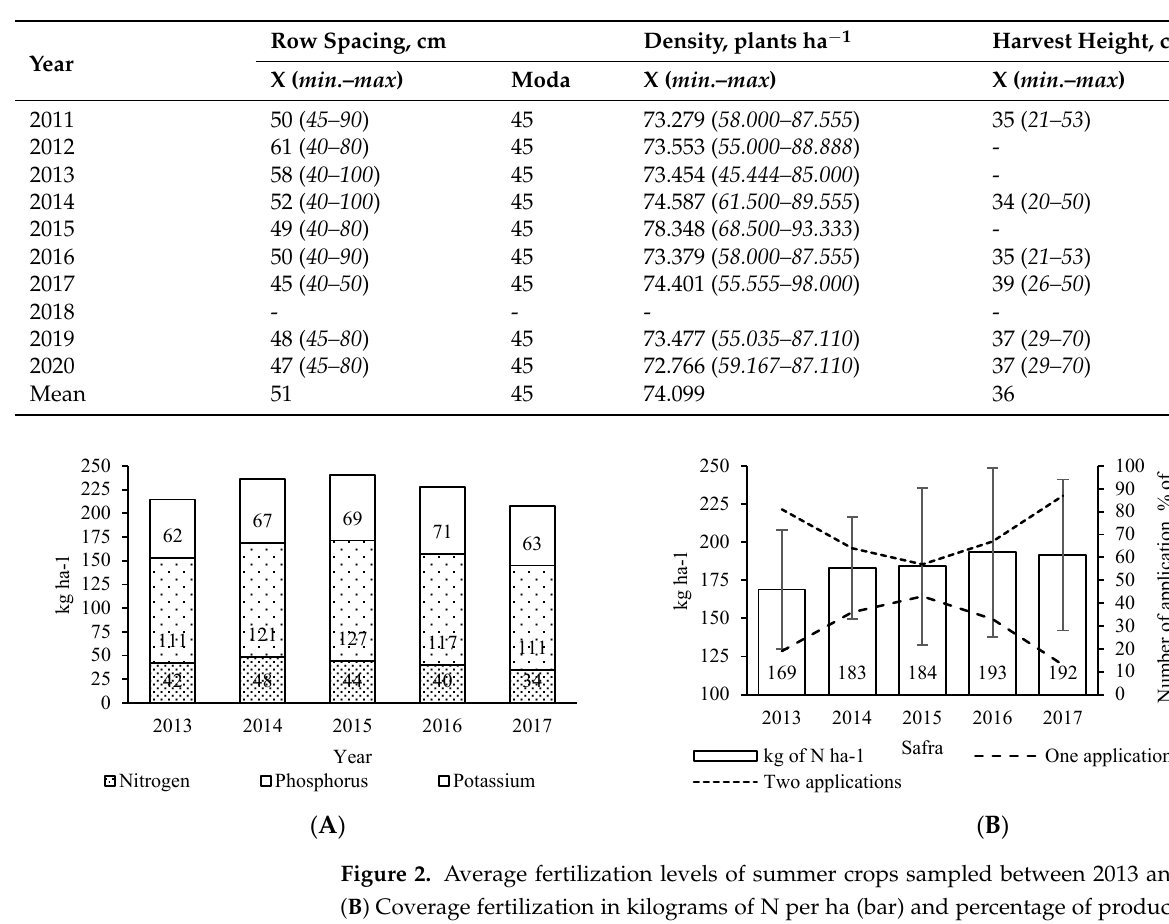
Table 4. Planting, harvesting, and morphometric characteristics of corn plants cultivated in the state of Paran á , Brazil for silage production between the years 2011